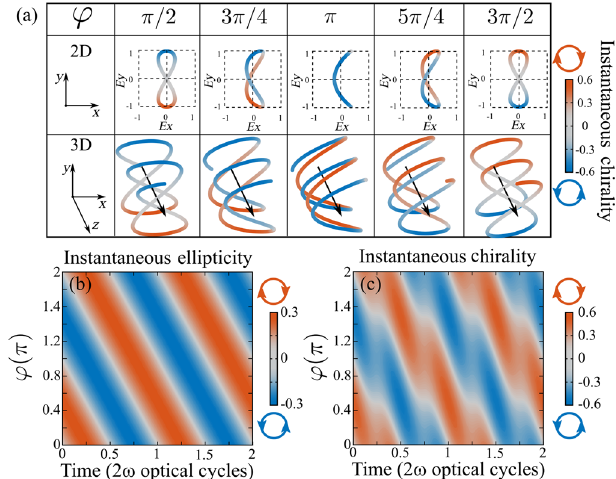
FIG. 2. Schematic description of the subcycle instantaneous ellipticity and optical chirality of the pulse. (a) 2D and 3D representations of the shape of a composite electric field obtained by combining a fundamental component at ω polarized along y and a 2 ω component along x , with 10% intensity ratio, for different relative phases φ between the two components. The color indicates the instantaneous chirality at each instant in the cycle. (b) Instantaneous ellipticity and (c) instantaneous chirality of the composite field along one laser cycle, as a function of φ . The instantaneous ellipticity and chirality are defined in the text [Eqs. (2) and (3)]. The instantaneous chirality is normalized relative to the chirality of a left-circularly polarized field. The normalization of the instantaneous ellipticity is implied in its definition. Note that in 2D representation of the 0 and π phases, we can see only the first half-cycle of the laser field. The second half-cycle is not visible since it traces exactly the same route as the first half, only in the reverse direction, which causes the chirality of the second half to be opposite to that of the first half, as seen in the 3D transverse ( x , y ) plane. For instance, the field exhibits a figure-eight shape aligned along y for φ ¼ π = 2 . Such a field can be intuitively understood as successive left and right elliptically polarized half-cycle components producing photoelectrons in the upper and lower hemispheres of the velocity map imaging (VMI) detector, respectively.